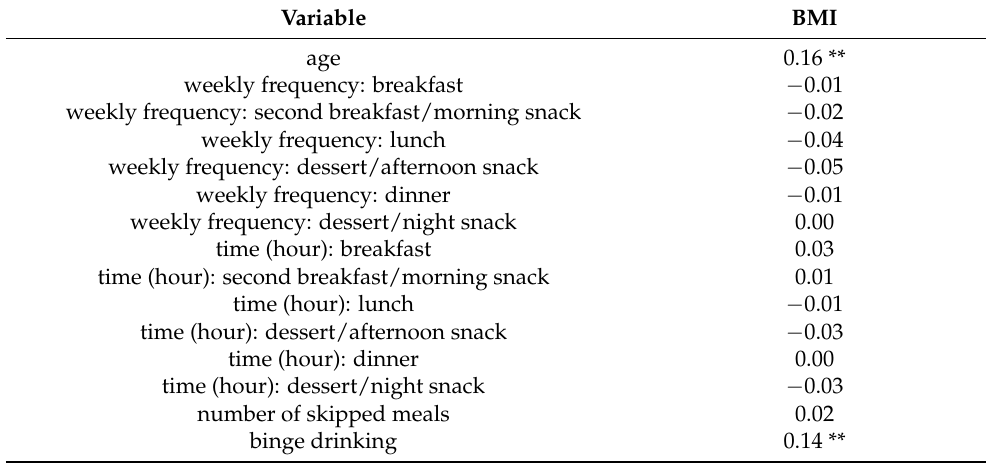
Table 4. Kendall’s tau-b correlation scores between variables and BMI levels (N =